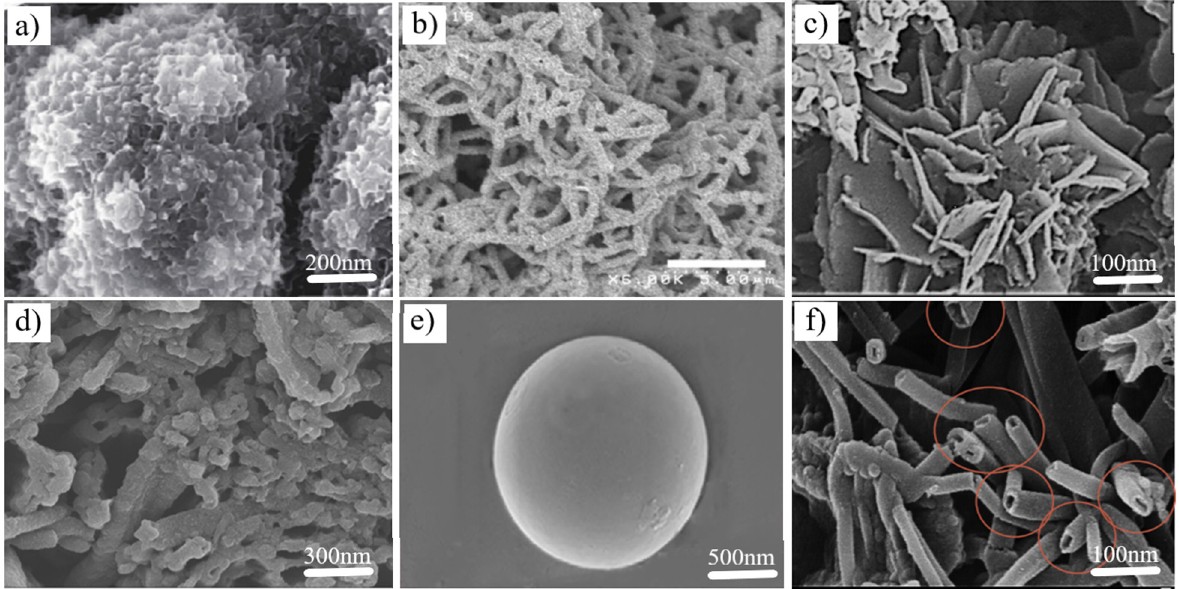
Figure 4. SEM images of different structures of PANI polymer: ( a ) 3D hierarchical PANI [28], ( b ) nanowire [29], ( c ) nanoflowers [30], ( d ) nanorods [31], ( e ) microspheres [32], ( f ) nanotubes [33].